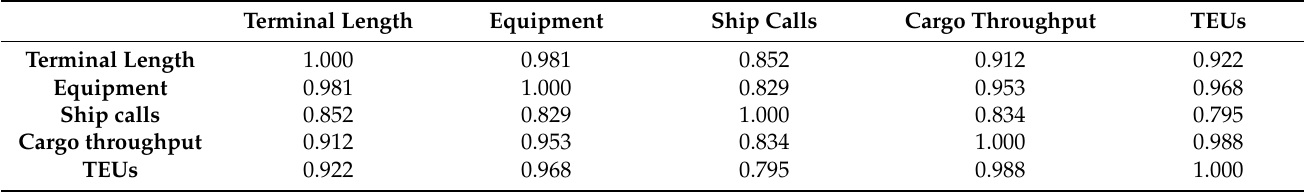
Table 5. Correlation matrix of inputs and outputs in 2020.